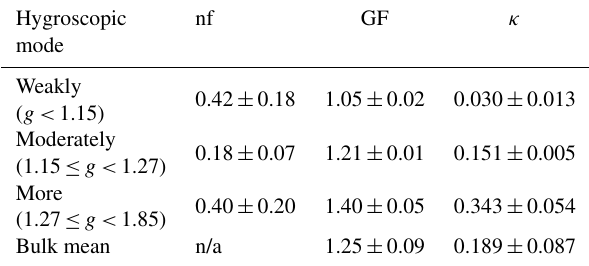
Table 4. The temporally mean number fraction (nf), volume- weighted mean diameter growth factor (GF), and κ results (mean ± SD) of 100nm wildfire haze particles in the three differ- ent hygroscopicity ranges at 85%